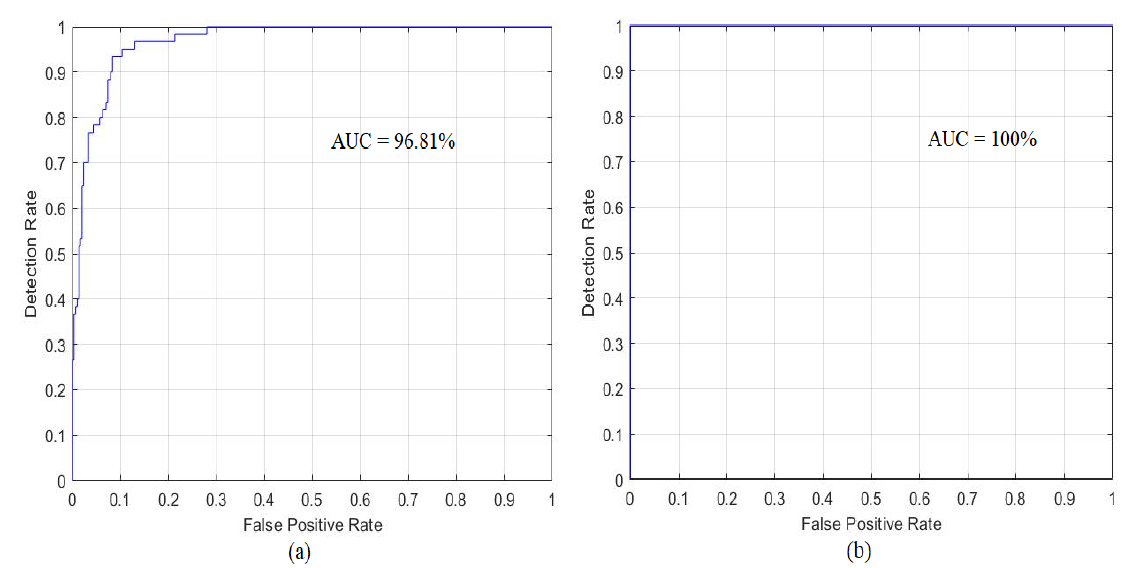
Figure 21. The ROC values reached by the AlexNet model considering the different datasets used. ( a ) The ISIC 2018 dataset. ( b ) The PH2 dataset.